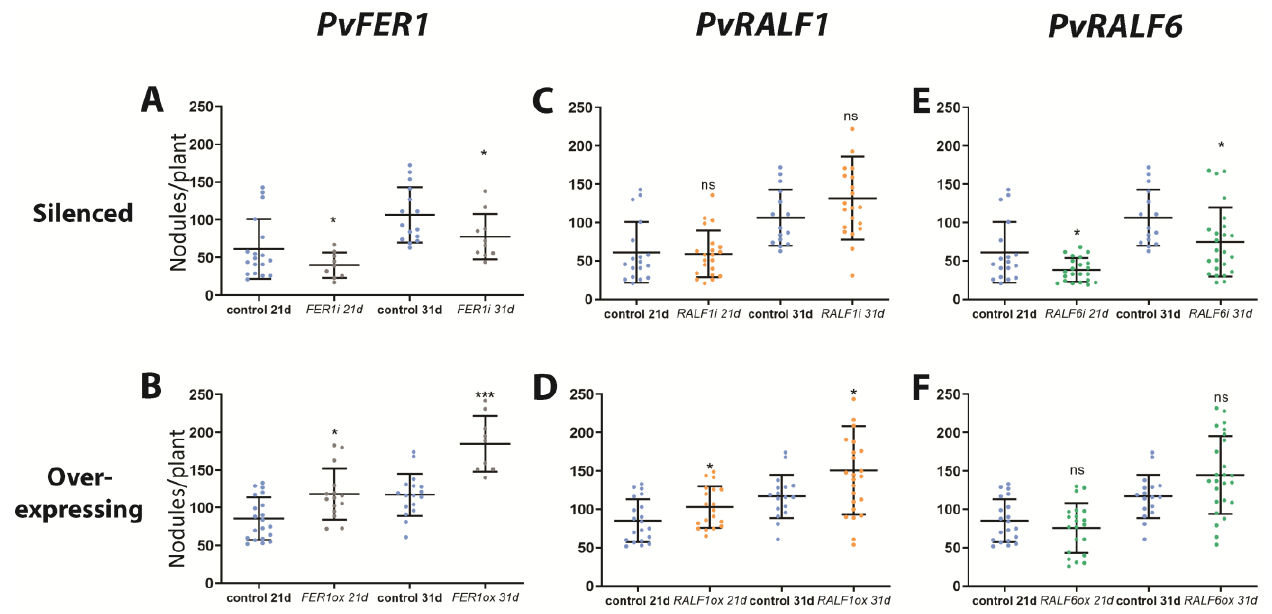
Figure 3. PvFER1 , PvRALF1 , and PvRALF6 have a positive effect in regulating the nodule number, in 0 mM nitrate. ( A – F ) Quantification of the number of nodules in PvFER1- (gray dots, A ), PvRALF1- (orange dots, C ), and PvRALF6 -silenced (green dots, E ), and PvFER1 - (gray dots, B ), PvRALF1 - (orange dots, D ), and PvRALF6 -overexpressing (green dots, F ) transgenic roots at 21 and 31 dpi and under 0 mM nitrate, and their corresponding control roots (SAC for silenced and GUS for overexpressing roots, blue dots). Lines represent the mean ± SD. Data from three independent experiments are plotted as dots ( n ≥ 9). A non -parametric Mann – Whitney test was used to assess significant differences. * p < 0.05, *** p < 0.001; ns = not significant.